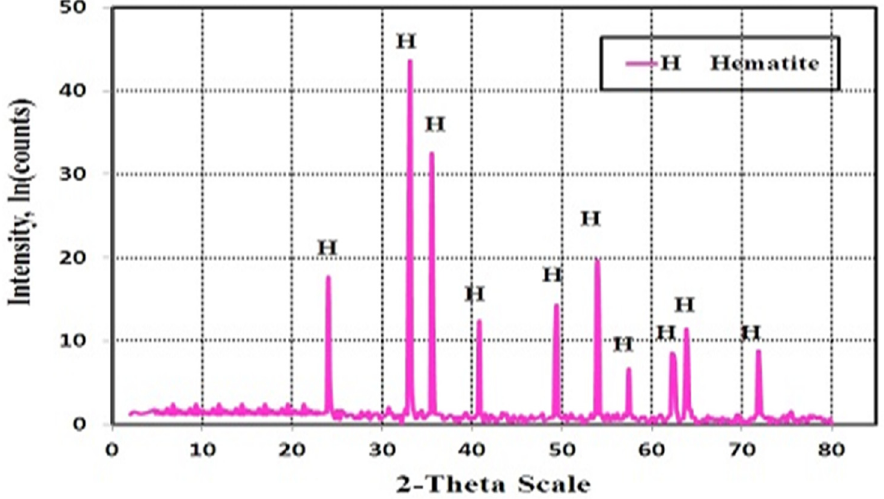
Figure 1. X-ray diffraction analysis of iron ore fines sample. Scanning electron microscope (SEM) JEOL, JSM-5410 at10Kv (JEOL ltd, Akishima,